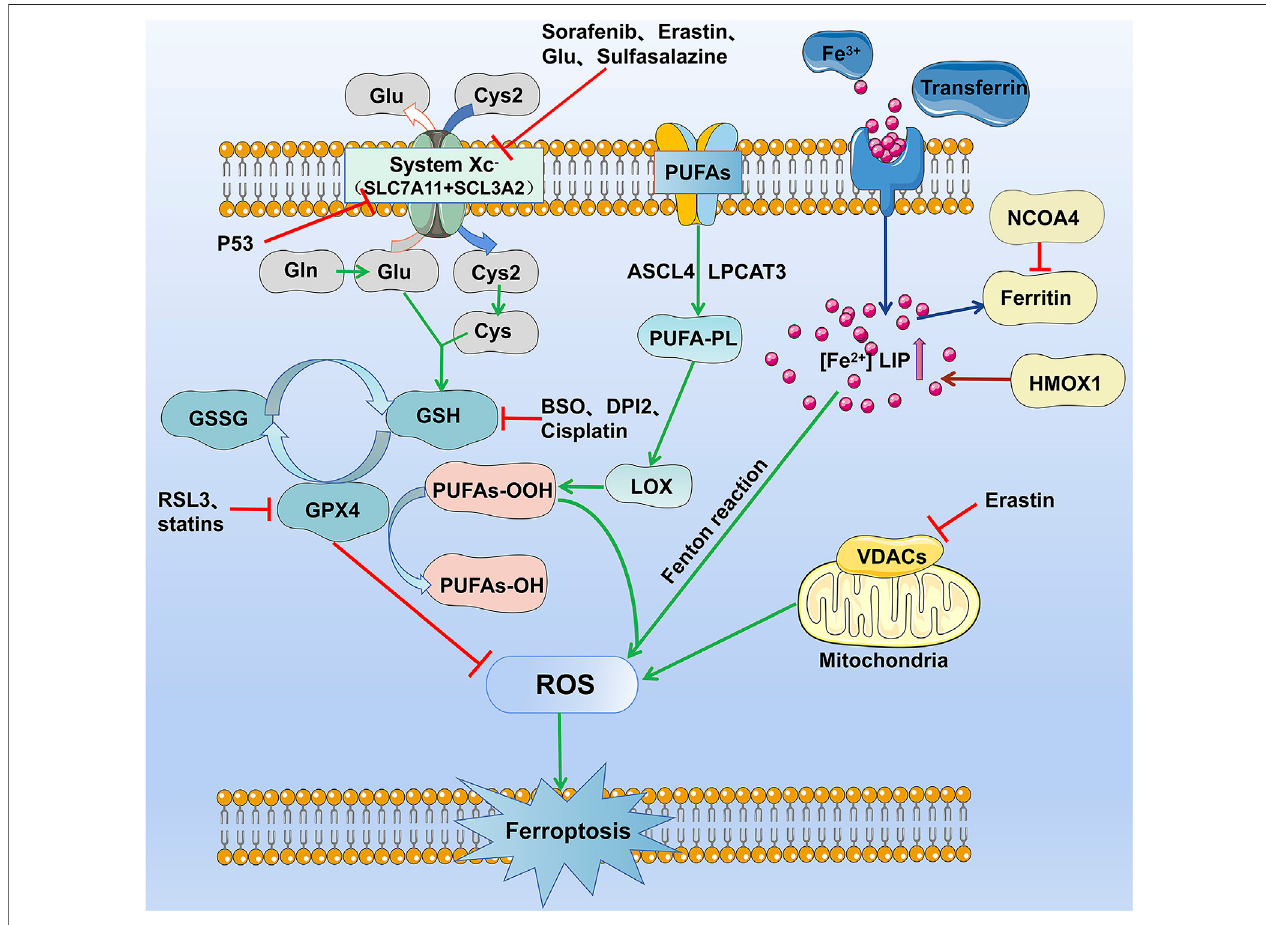
FIGURE1| Theoccurrenceandregulationmechanismofferroptosisincells.The fi gurehighlightsthe fi vecurrentlyknownmechanismsinvolvedinferroptosis:lipid reactive oxygen metabolism pathway, cystine glutamate transport receptor (System Xc-) metabolic pathway, iron metabolism pathway, and VDAC receptor pathway.